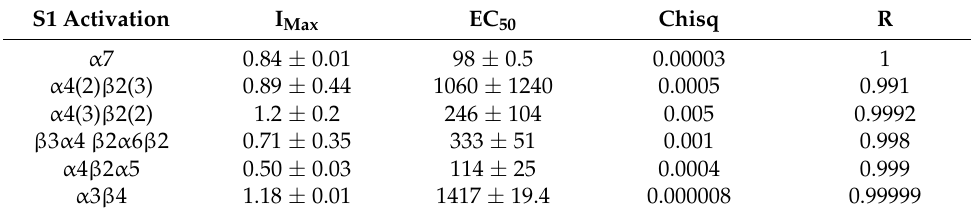
Table 2. Parameters extracted from curve fits for Figure 6.